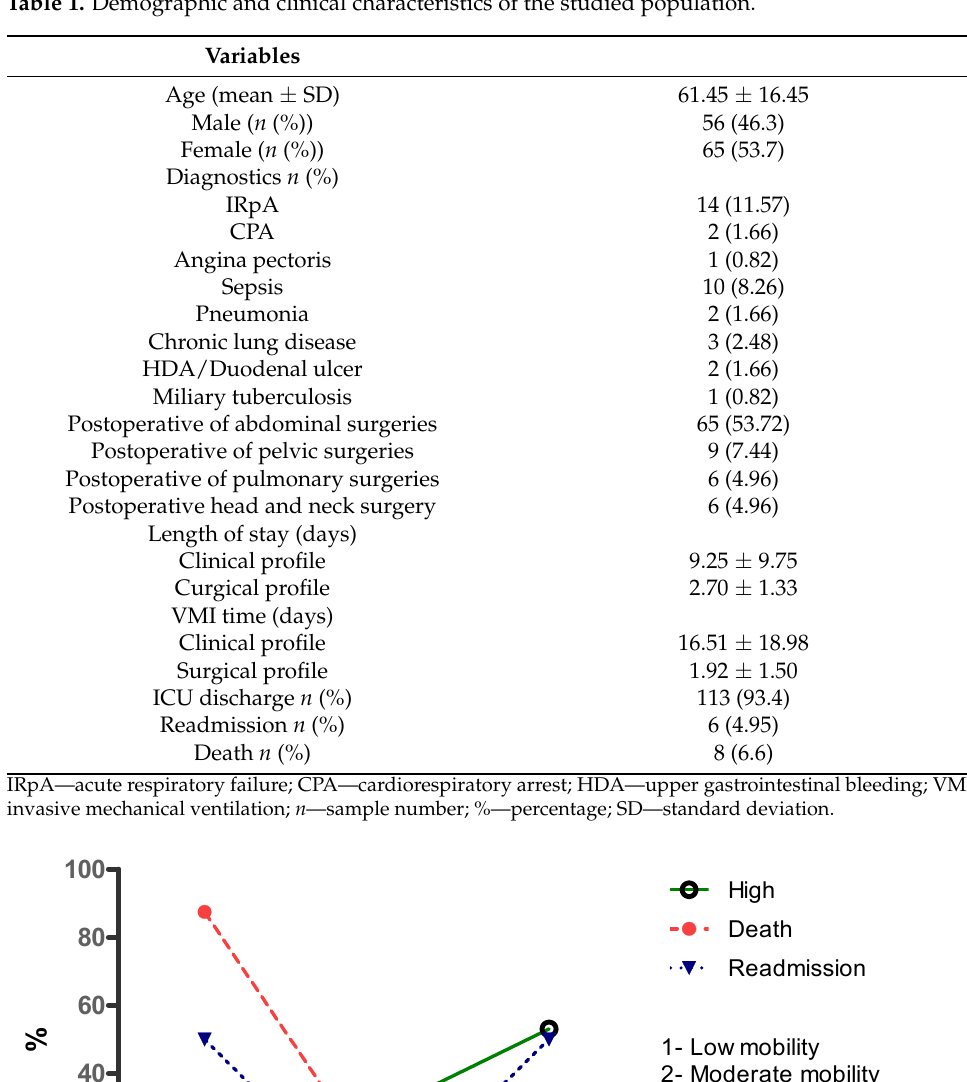
Table 1. Demographic and clinical characteristics of the studied population.